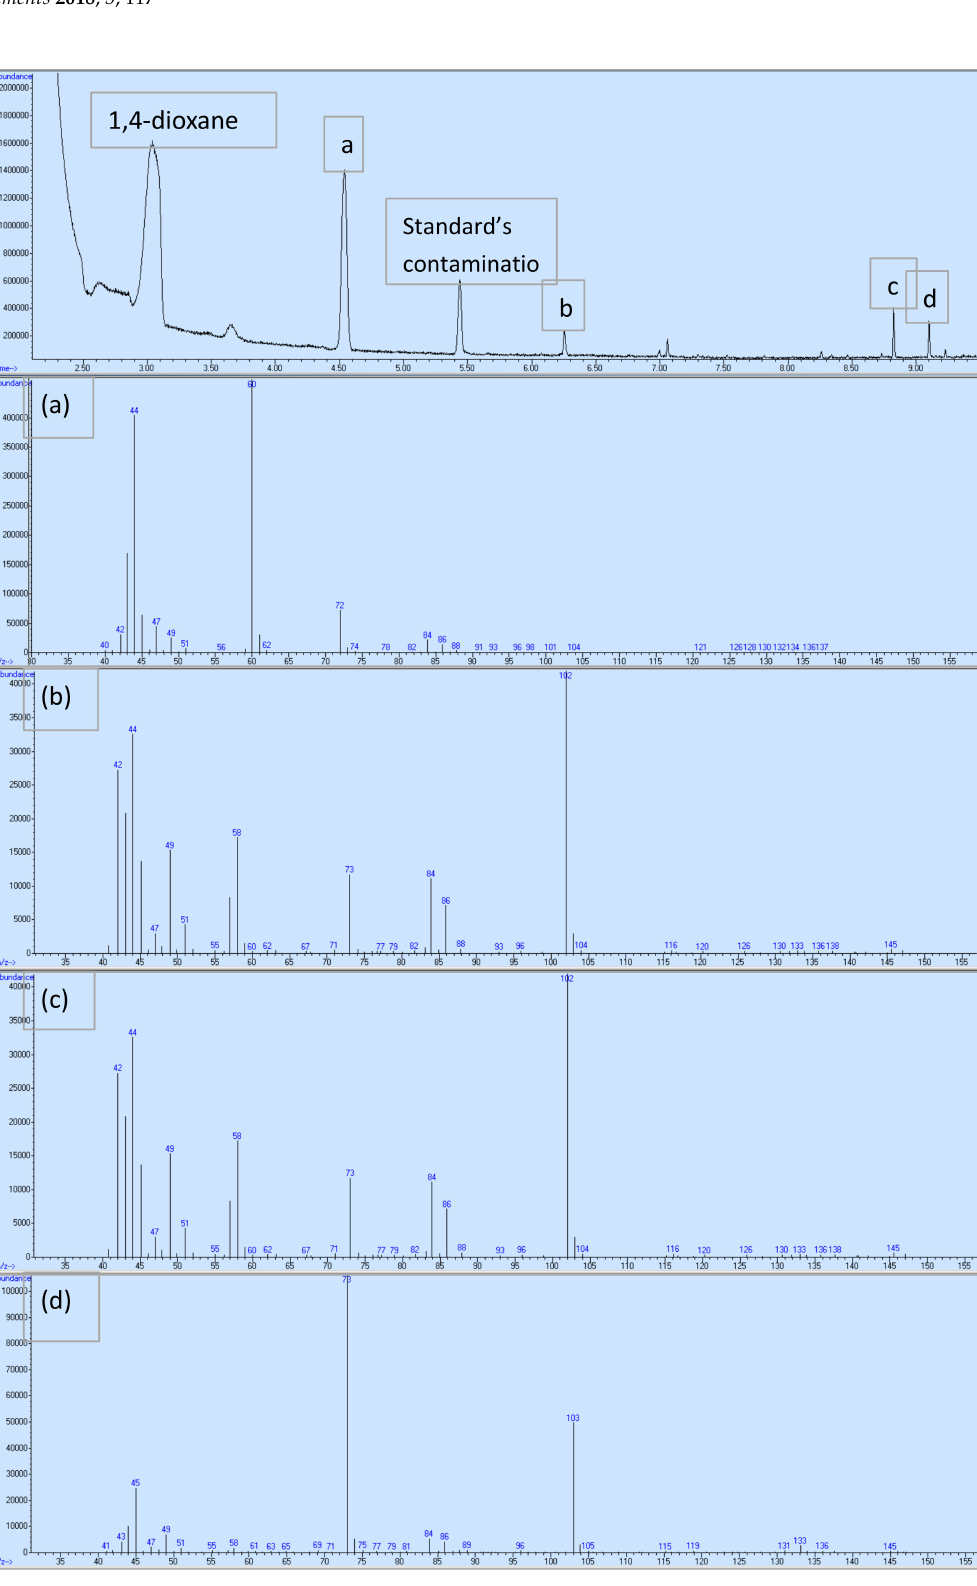
Figure 6. The MS chromatogram of the UV/NO 3 degradation of 1,4-dioxane (upper part) and mass spectra of the detected intermediates (parts ( a – d )), taken from an experiment with 5 mg N/L nitrate after 15 min (Figure